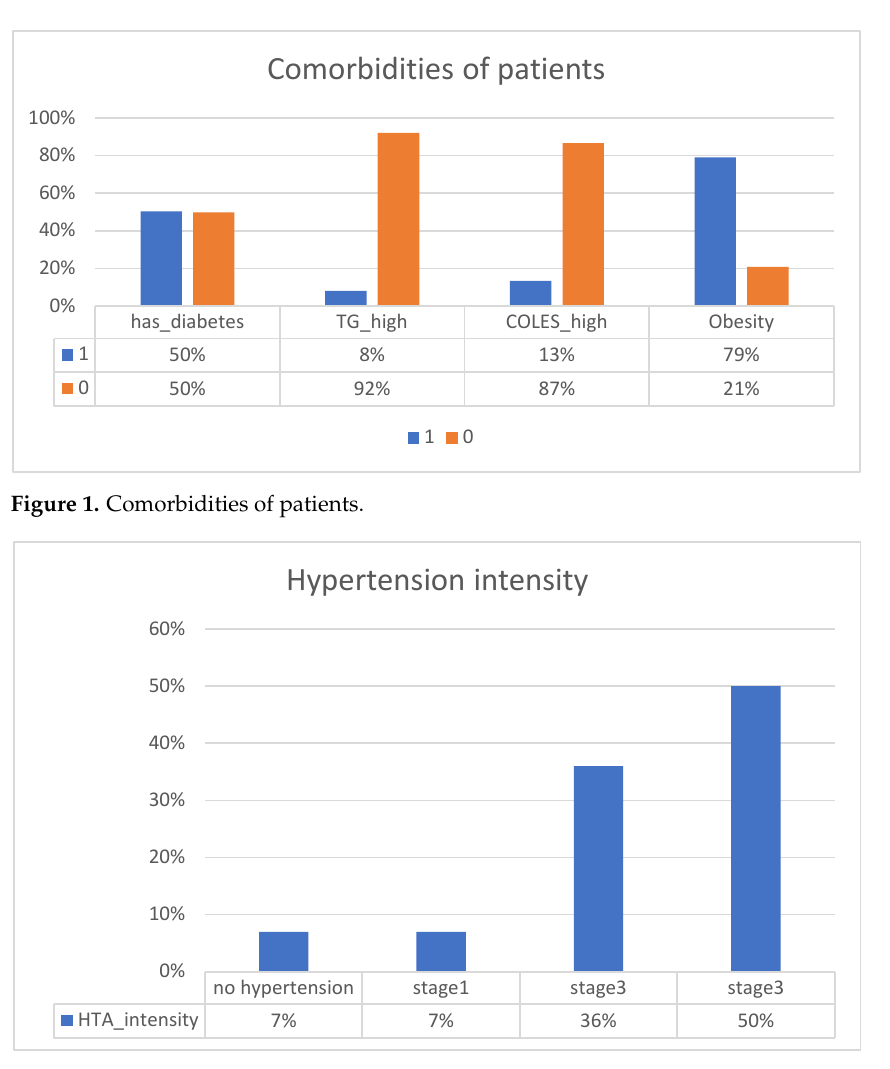
Figure 2. Hypertension intensity.